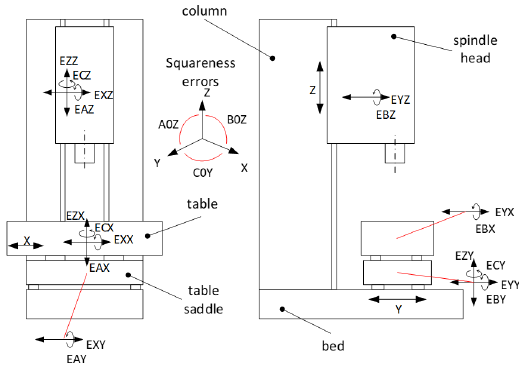
Figure 5. Geometric errors of the three-axis vertical machining centre [5].